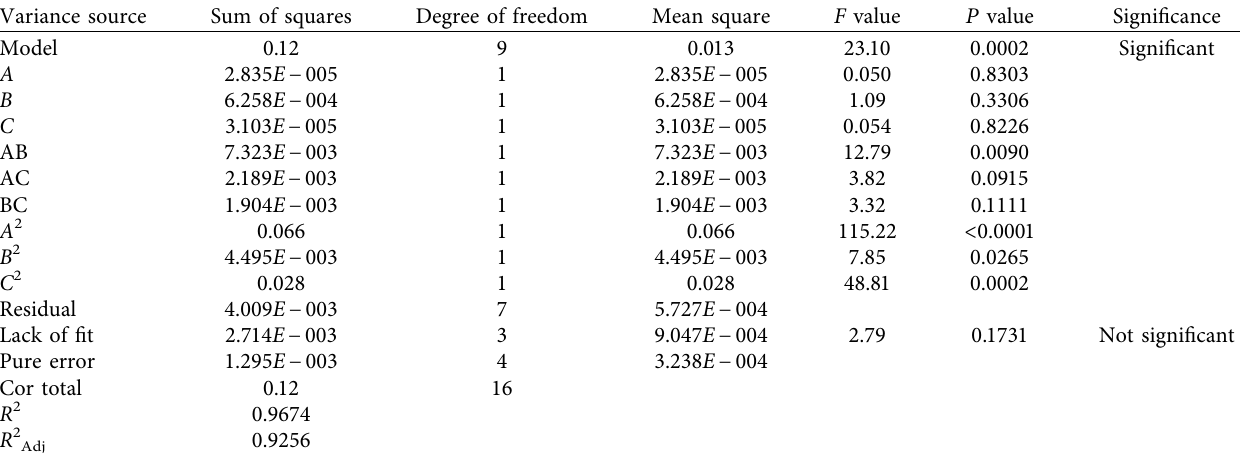
Table 7: Variance analysis of the Box–Behnken